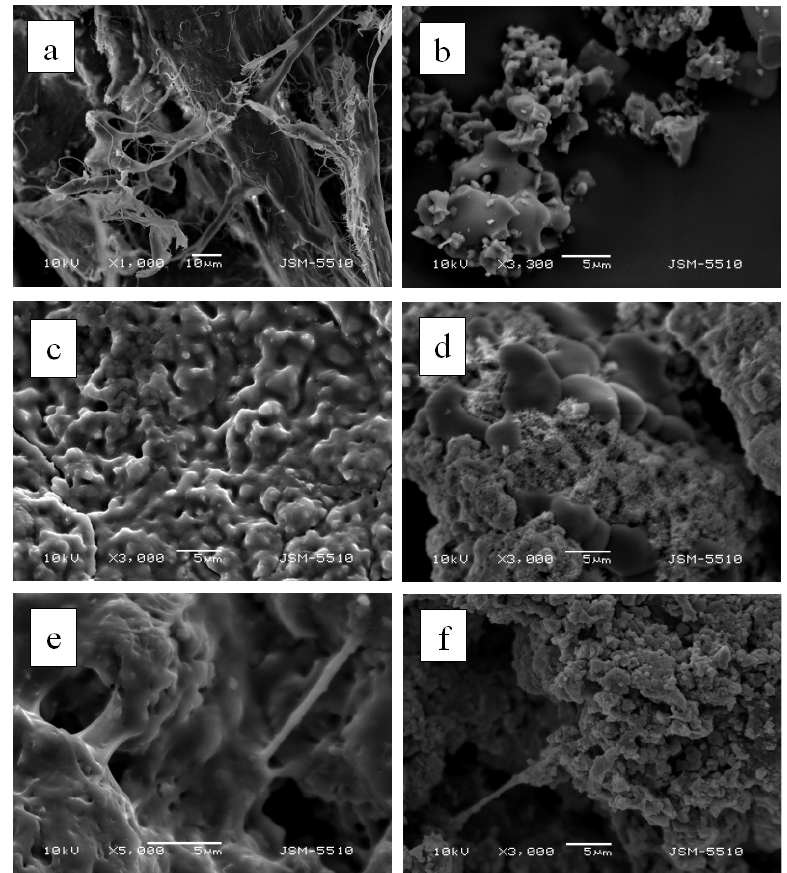
Figure 8. SEM images for pure collagen (a), silicocarnotite (b), silicocarnotite/collagen 75:25 wt% (c), silicocarnotite/collagen 25:75 wt% before SBF (d), silicocarnotite /collagen 75:25 wt% (e), silicocarnotite /collagen 25:75 wt% after immersion in SBF for 3 days